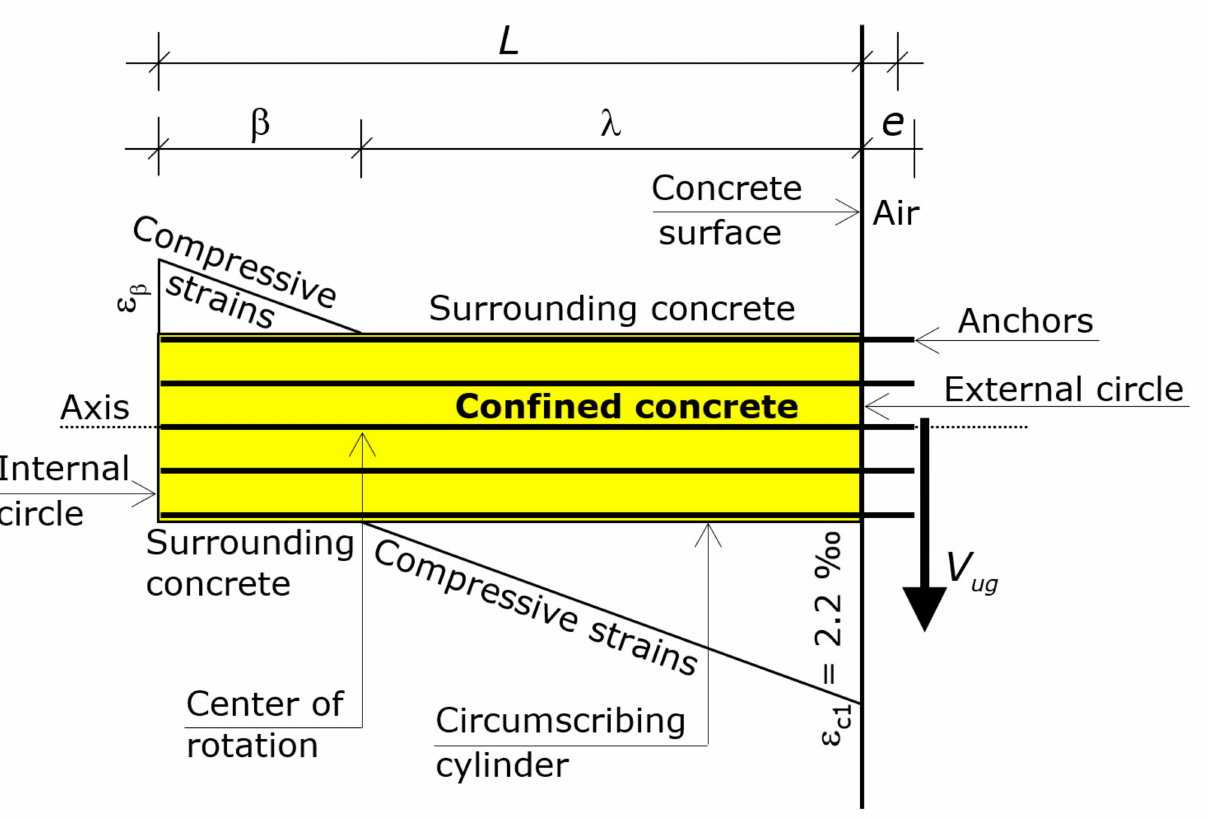
Figure 6. Profile of the compression strains at the interface between the circumscribing cylinder and the surrounding concrete. Strains vary along z but do not vary along x